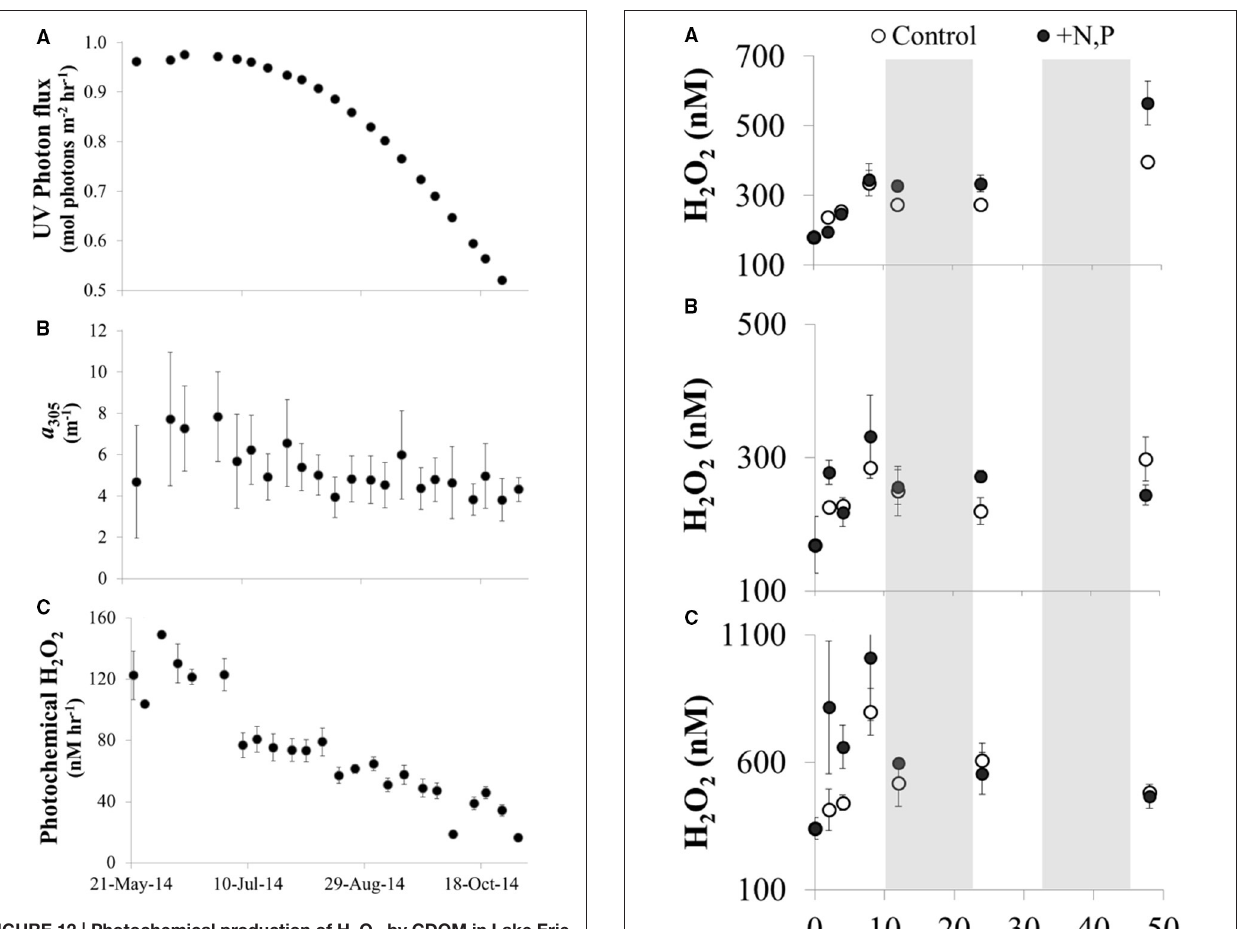
FIGURE 12 | Photochemical production of H 2 O 2 by CDOM in Lake Erie during summer 2014. (A) Modeled UV reaching the surface of Lake Erie at noon on each date that water samples were collected in 2014. (B) CDOM absorption coefficient at 305nm vs. date (average CDOM absorption coefficient across all sites for each date). (C) Calculated photochemical production of H 2 O 2 in Lake Erie (average H 2 O 2 production across all sites for each date) calculated as described in Equation (3) using the modeled UV for the time of sample collection, the CDOM spectrum of the water sample, and a single, best fit apparent quantum spectrum ( 8 λ ) for H 2 O 2 production.